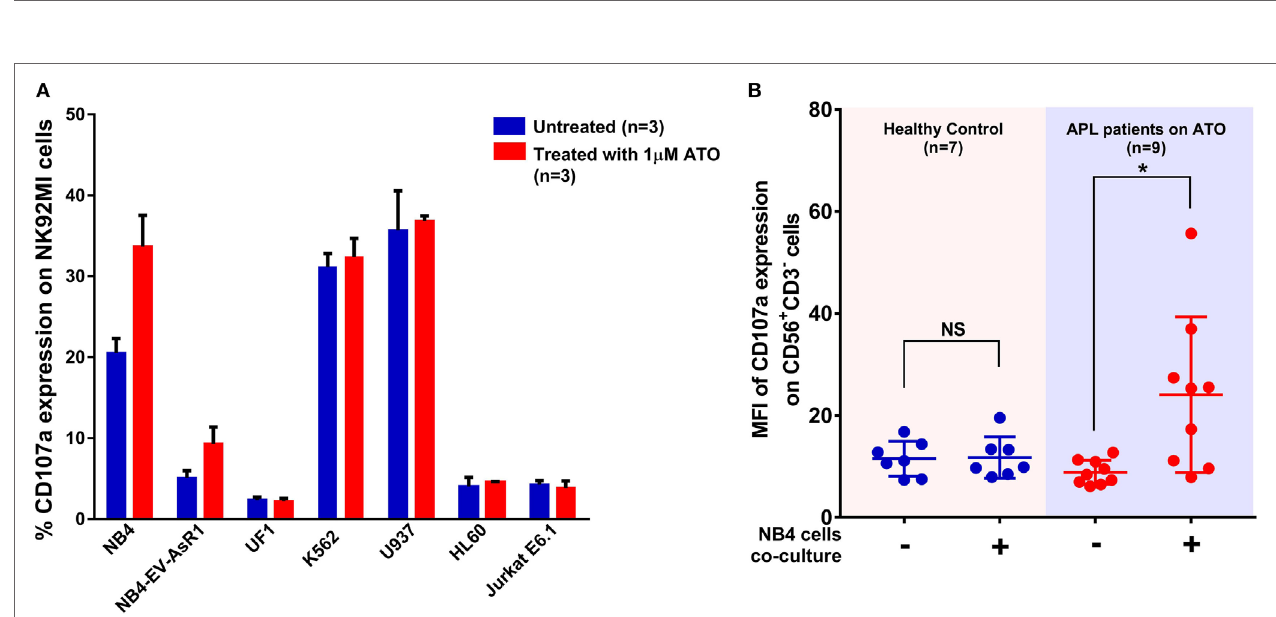
FigUre 3 | Arsenic trioxide (ATO) enhances the cytolytic activity of NK cells. (a) Bar graphs showing the percentage expression of CD107a (a marker for degranulation of NK) when NK cell lines were cocultured with leukemic cell lines at the ratio of 2:1 for 5 h. The blue bars represent the experiment with untreated leukemic cell lines and the red bars represent the experiment after exposure of leukemic cell lines to 1 μ M ATO for 12 h ( n = 3). (B) Graph shows the mean fluorescence intensity (MFI) of CD107a expression gated on CD56 + CD3 − cells obtained from PBMNCs of healthy controls (no ATO exposure; n = 7) and acute promyelocytic leukemia (APL) patients (under ATO treatment; n = 9) with and without co-culture of NB4 cells at the ratio of 2:1 for 5 h.